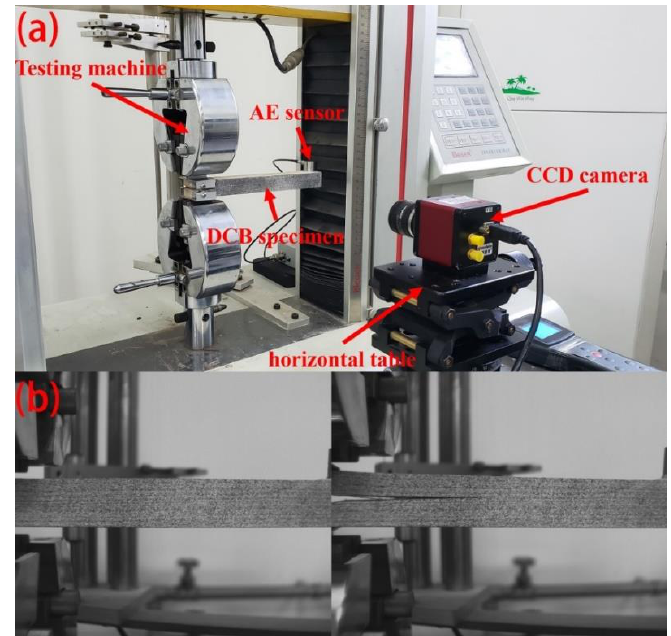
Figure 5. ( a ) Test device schematic. ( b ) Crack growth tracking.